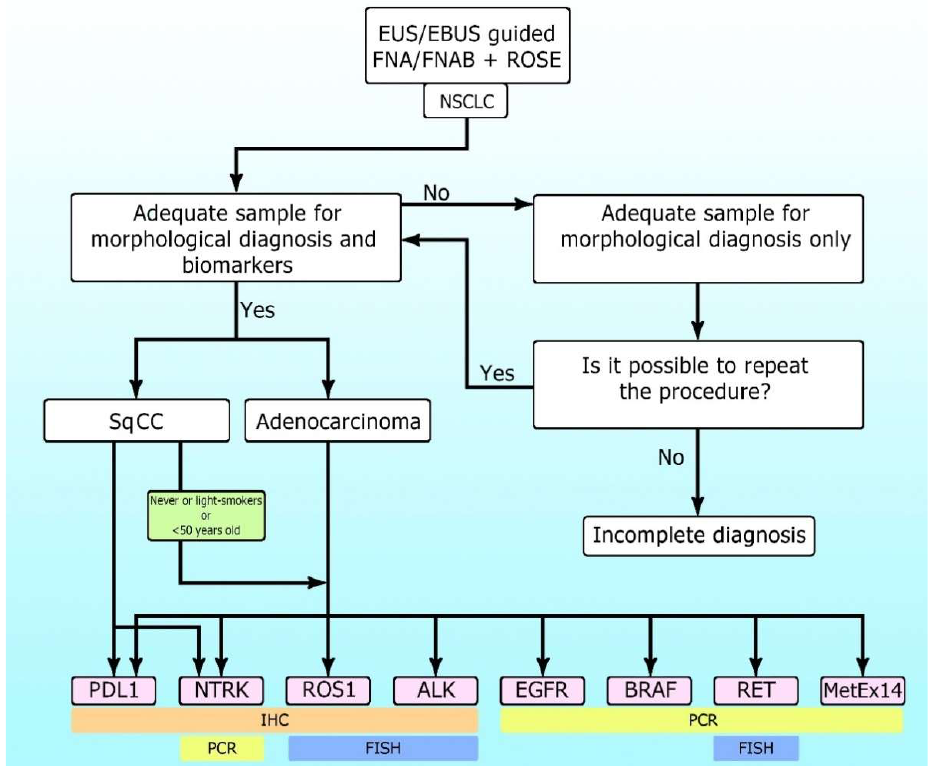
Figure 1. The algorithm for sample collection morphological and biomarker diagnosis in non-small cell lung cancer (NSCLC).